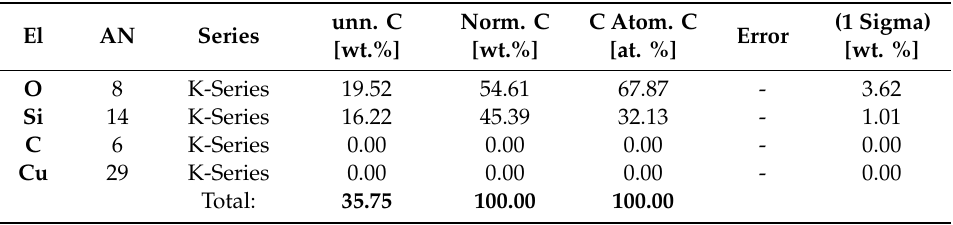
Figure 10. TEM images of silica NPs and their: ( a ) Particle size distribution, ( b ) spherical morphology. Table 4. Elemental analysis of SiO 2